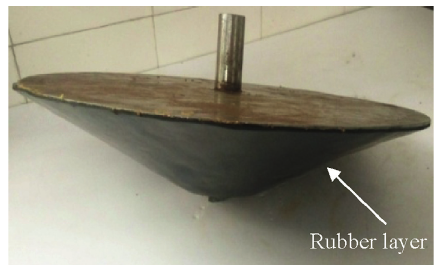
Figure 14: CHFRF with the rubber layer.